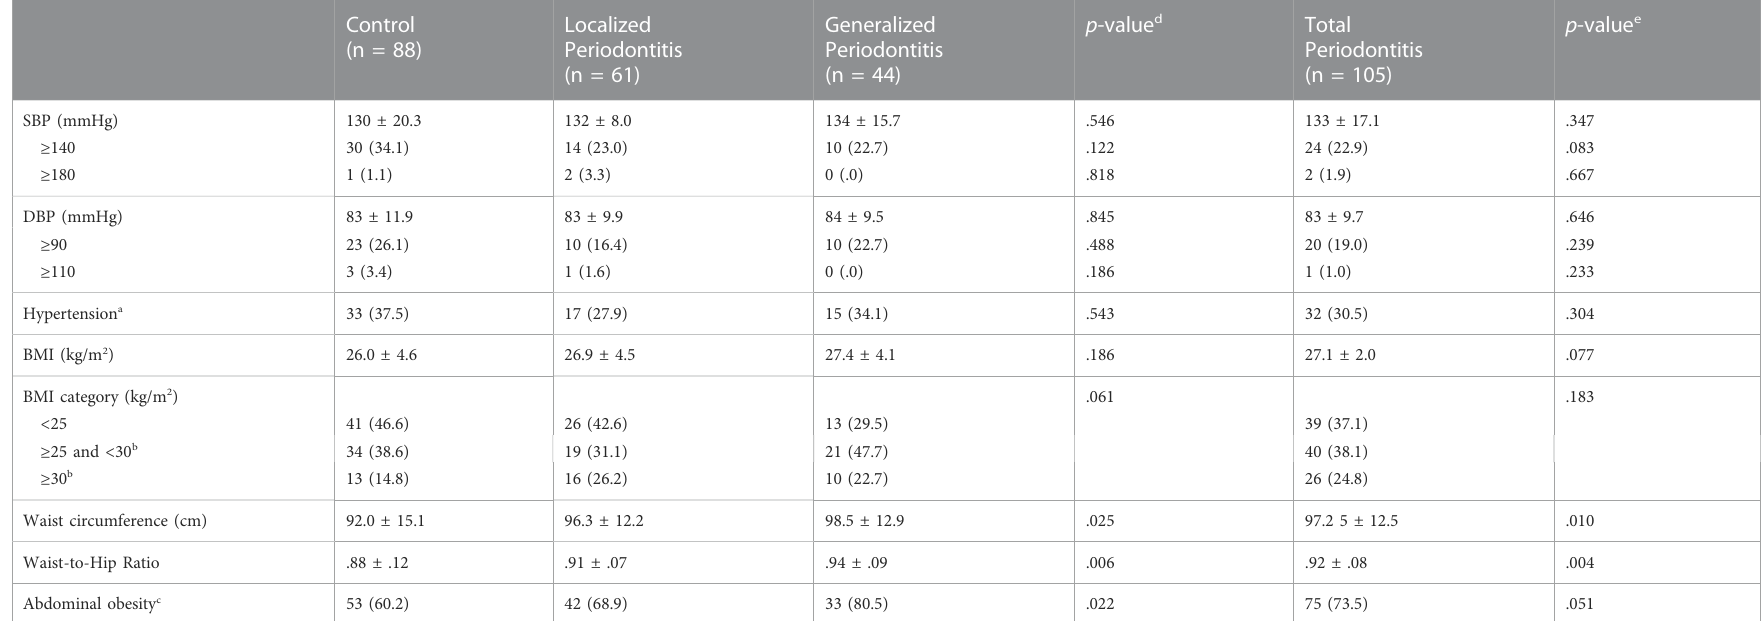
TABLE 4 Results of clinical assessments of parameters related to general health and cardiovascular